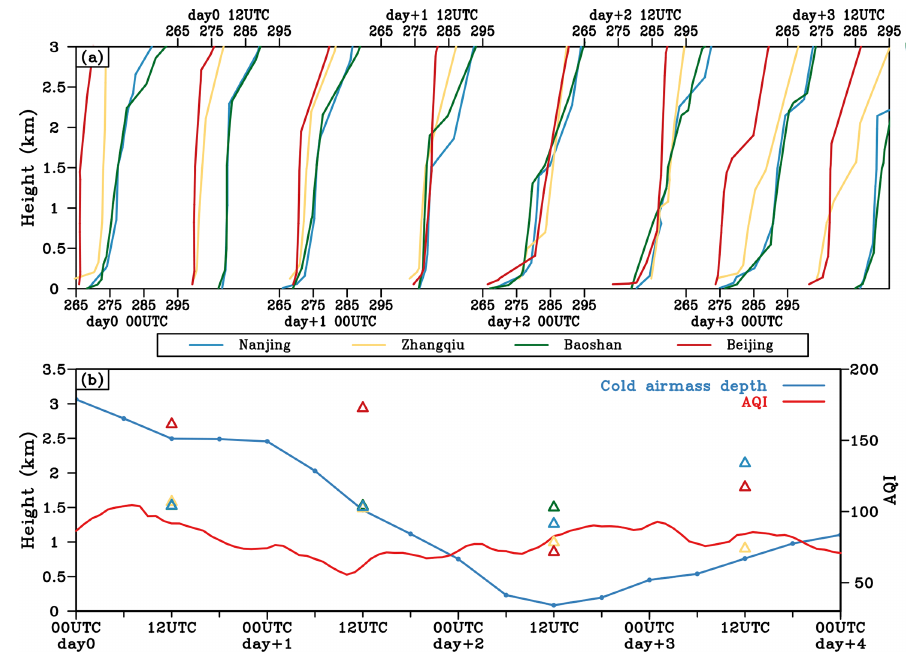
Figure 8. The same as Fig. 7 but during a CAO_slow event from 11 to 14 February 2018.